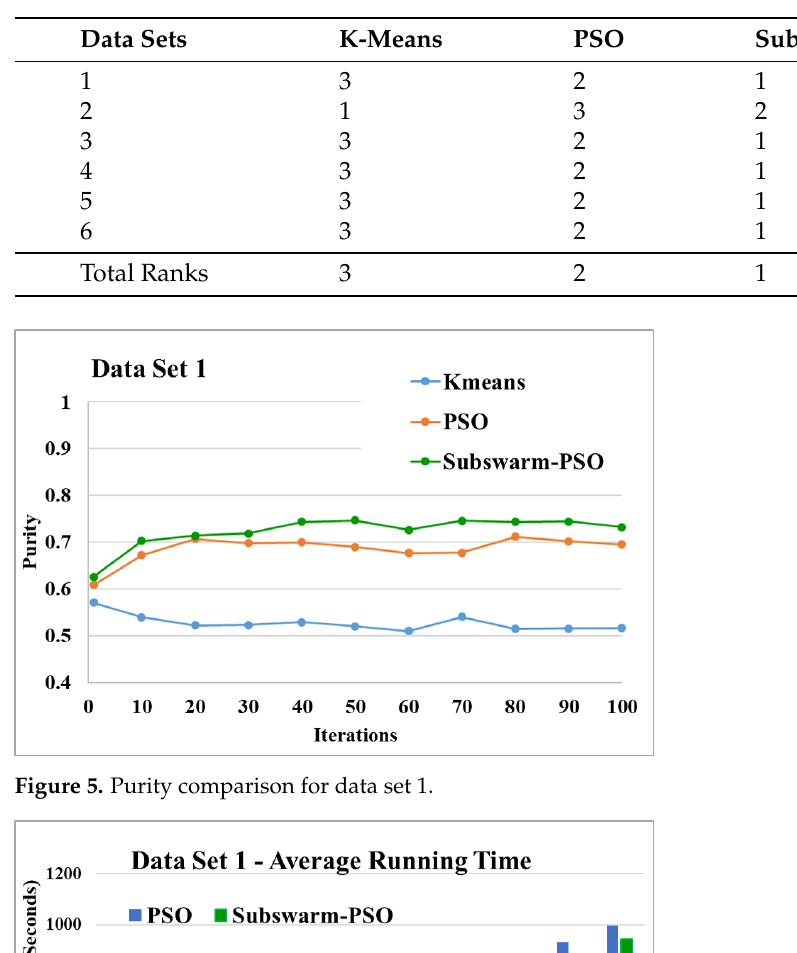
Table 6. Ranking table of purity mean values for text document clustering algorithms.